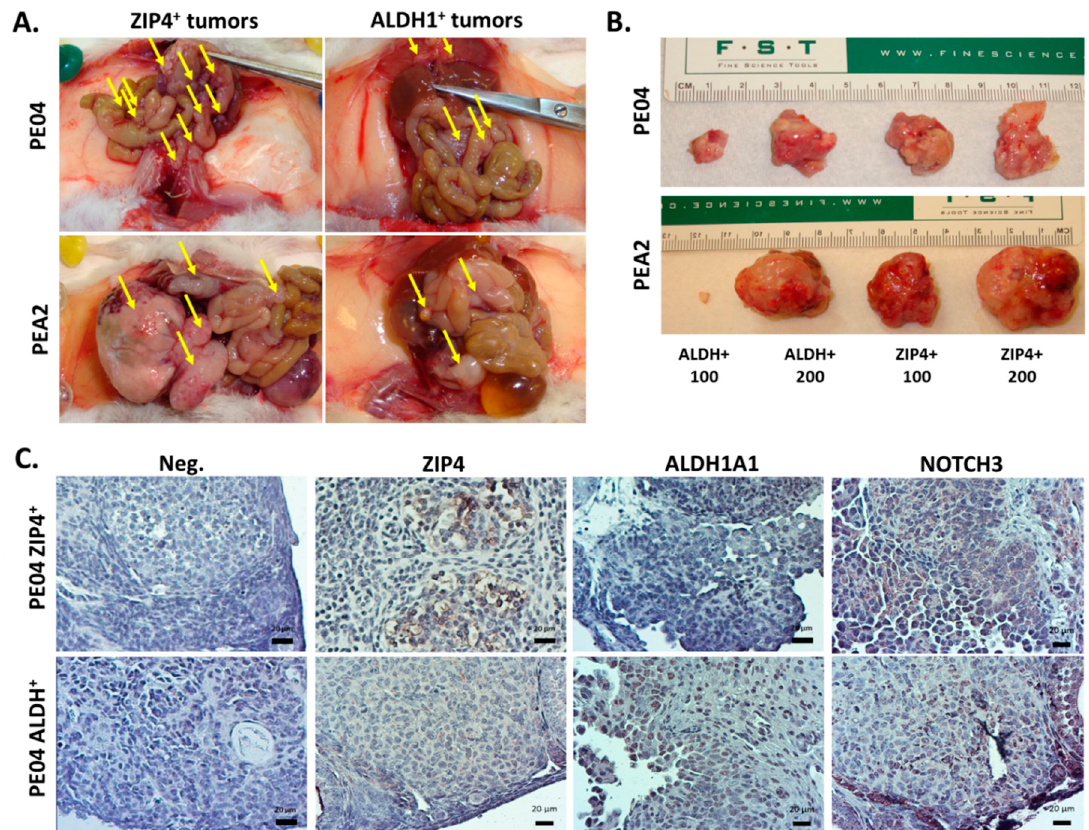
Figure 4. ZIP4 + cells exhibited higher tumor formation abilities compared to other groups of cells ( A ) Representative photographs of mice i.p. injected with PE04 ZIP4 + , PE04 ALDH + , and PEA2 ZIP4 + , cells with some tumor burdens are arrow-indicated. ( B ) Tumors generated from low numbers of ZIP4 + and ALDH + cells (s.c. injected). ( C ) Representative photographs of IHC staining of ZIP4, ALDH1, and NOTCH3 in ZIP4 + and ALDH + tumor sections. Scale Bar = 20 µ m. The dark purple / brown or dark blue colored cells above the background are positive stained. Representative results are shown for more than three independent experiments.